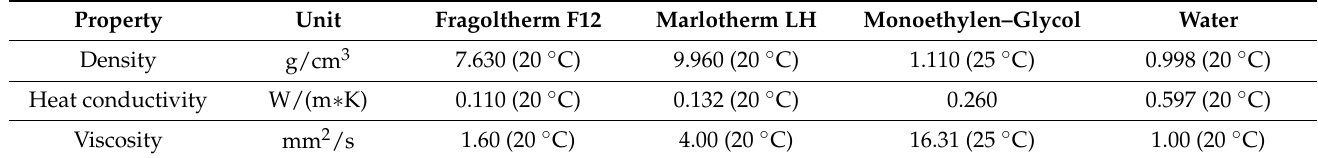
Table 1. Physical properties of the investigated heat transfer fluids